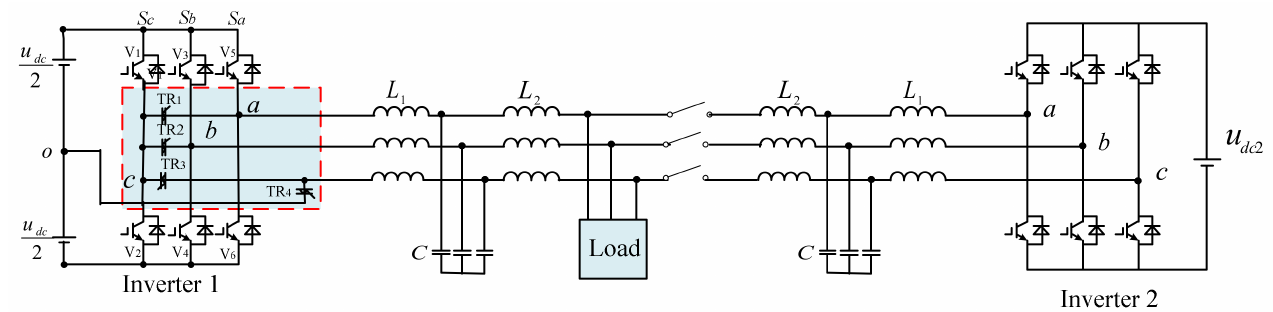
Figure 1. Topology of the off-grid microgrid with the reconfigurable inverter 1.